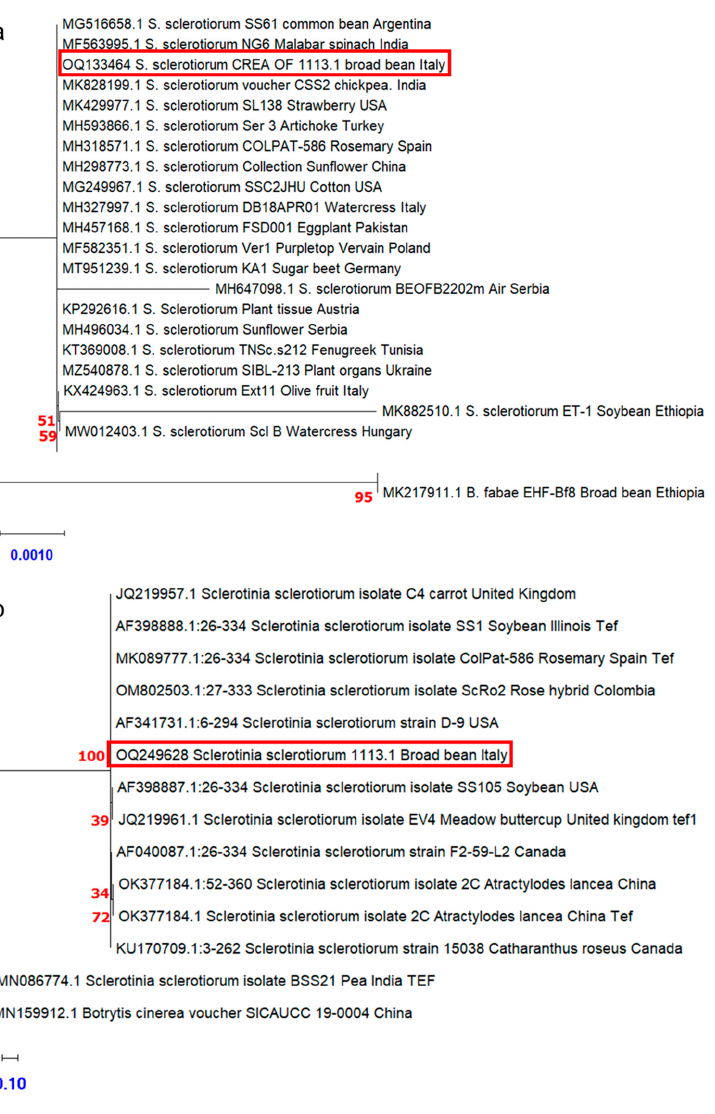
Figure 7. Dendrogram illustrating the evolutionary history of the isolated CREA OF 1113.1 inferred by ITS ( a ) and TEF1 - α ( b ) DNA sequencing. For each taxon, the graph reports the GenBank accession number, the three-letter code pathogen species, the two-letter ISO country code, and the host plant species within vertical lines. The percentage of replicate trees in which the associated taxa clustered together in the bootstrap test (500 replicates) is shown. The tree is drawn to scale, with branch lengths in the same units as those of the evolutionary distances. Maximum Composite Likelihood method used to infer the phylogenetic tree. Red squares highlight the position of S. sclerotiorum CREA OF 1113.1. Numbers in red indicates the bootstraps for the nodes and the scale bar was reported in blue. Phylogenetic analyses were conducted in MEGA X.